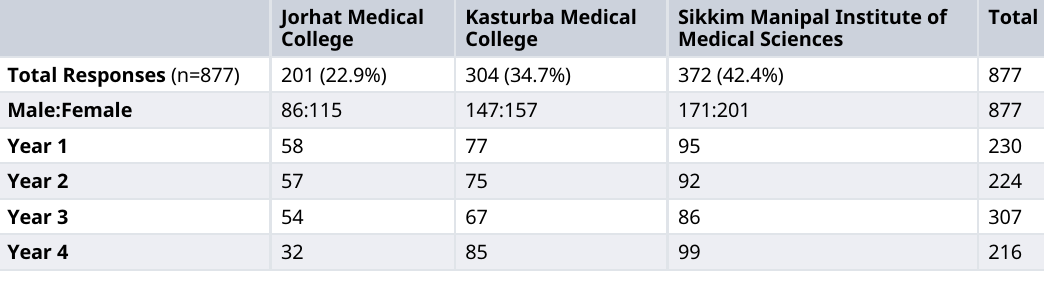
Table 3. The total responses of students from each center and other characteristics.